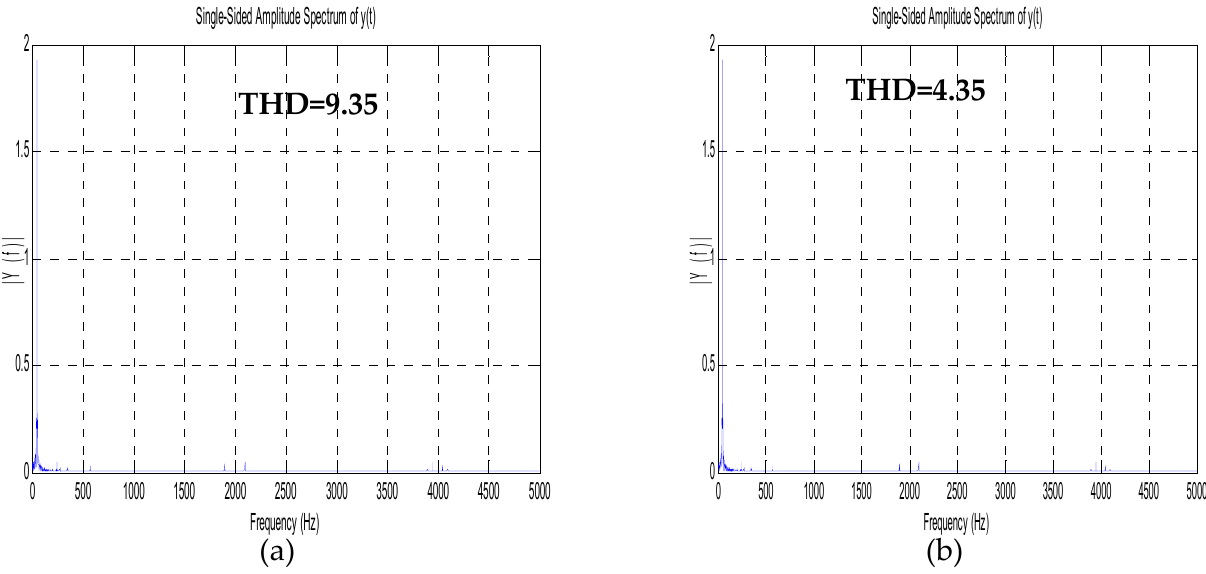
Figure 16. Comparison between 2L_FOC and 3L_FOC in open and closed loop conditions in terms of: ( a ) Current THD for 2L_FOC; ( b ) Current THD for 2L_FOC.